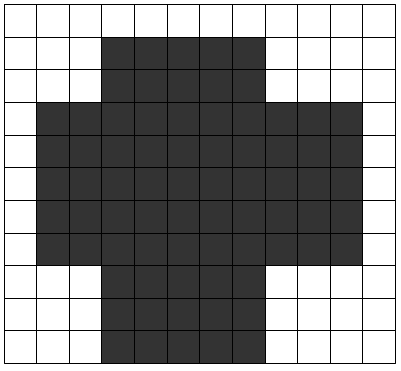
Figure 7. The unit cell of configuration B.